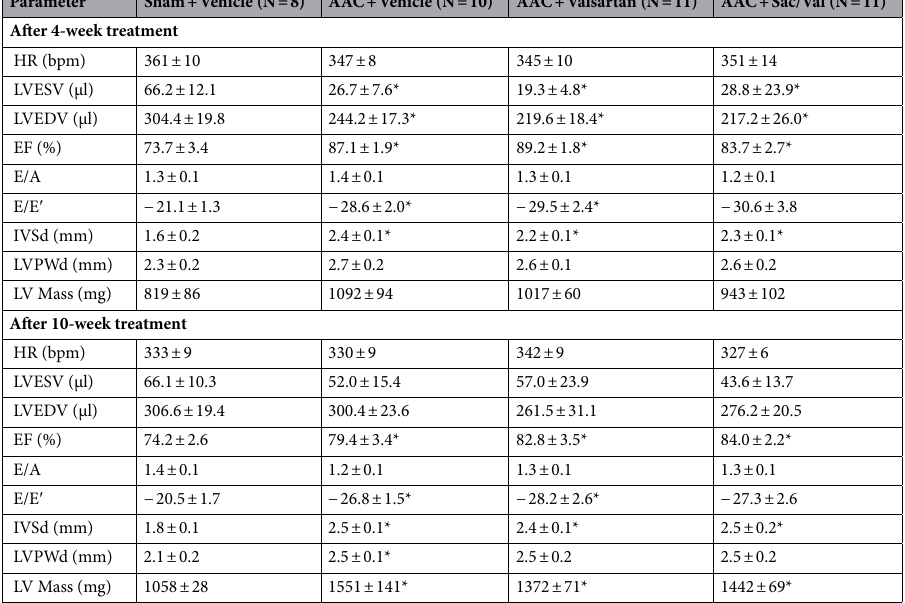
Table 1. Echocardiographic measurements of operated rats after 4- and 10-week treatments with vehicle (H 2 O), valsartan (31 mg/kg/day), and sacubitril/valsartan (Sac/Val, 68 mg/kg/day). HR: heart rates; LV: left ventricle; LVESV: LV end-systolic volume; LVEDV: LV end-diastolic volume; EF: ejection fraction; E/A: ratio of the early to late mitral inflow velocities; E/E ′ : ratio between early mitral inflow velocity and mitral annular early diastolic velocity; IVSd: Interventricular septal at the end of diastole; LVPWd: Left ventricular posterior wall at the end of diastole. Mean ± SEM. * P < 0.05 versus Sham +